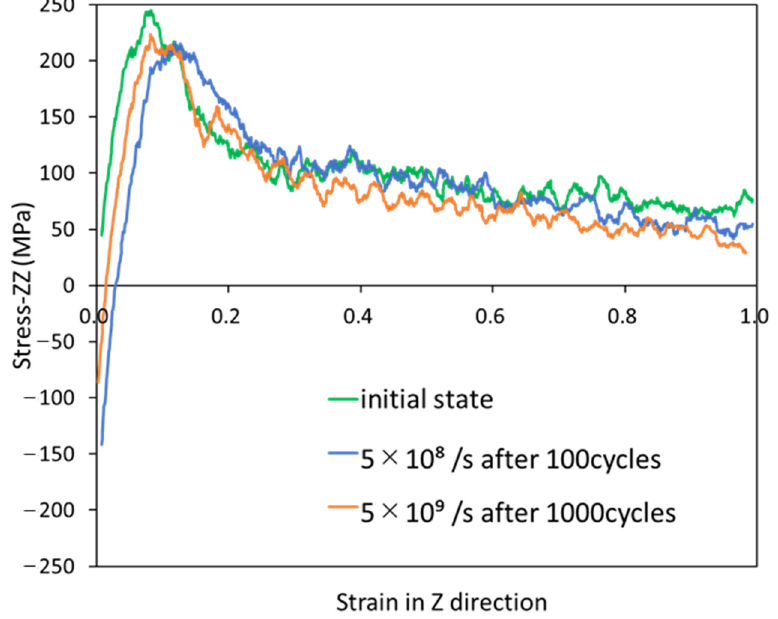
Figure 10. Stress–strain curves for uniaxial tensile calculations with three different initial structures.